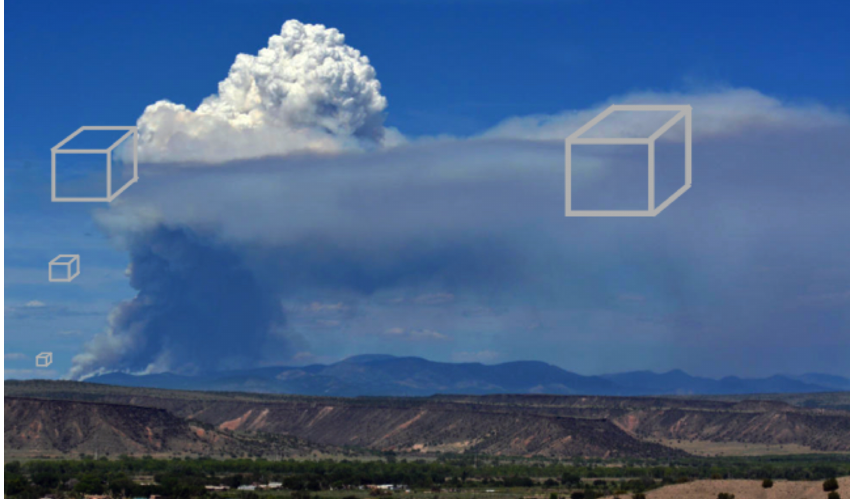
Figure 5. Inflow of air into an expanding fire plume; a likely near-fire aircraft sampling location would be near the cube on the upper right. Cubes are shown with 3-D sizes proportional to the number of moles of entrained air. These may be considered volumes of air adjusted downwards to compensate for the adiabatic expansion that rising plumes undergo. The smallest cube is taken to be near the flames, at roughly the point where fire emissions transition from mixing to entraining background air. Exact placement of this cube is not important to the analysis of entrainment, expansion, and tracer mixing ratio. Successively larger cubes have volumes roughly in the ratio of 1, 40 (partially raised), and 140 (near-neutral buoyancy level); sizes are consistent with a buoyant fire plume (Lareau and Clements, 2017). The rightmost cube has a ratio to the first of 400, consistent with horizontal Gaussian dispersion during travel downwind. See text for more